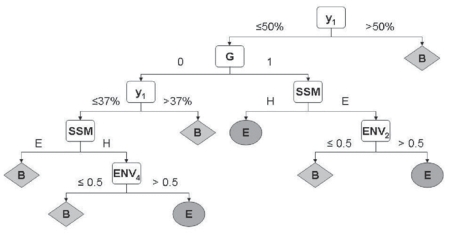
Prediction of relative solvent accessibility. Decision tree selected in a two-states model (B = buried, E = exposed) with a threshold of 16%. G = group parameter, ENV = environment parameter, SSM = secondary structure − major state, y1 = topohydrophobic index.